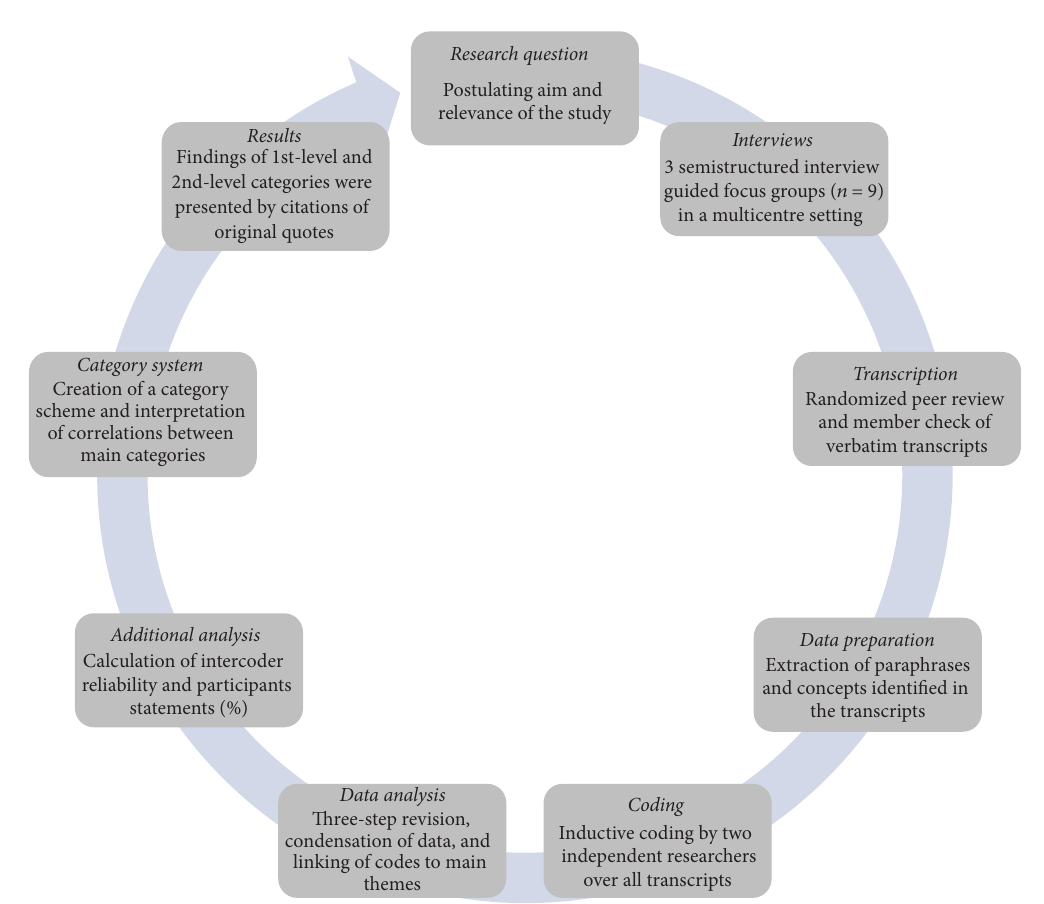
Figure 2: Qualitative research circle applied in the present work: from research question to